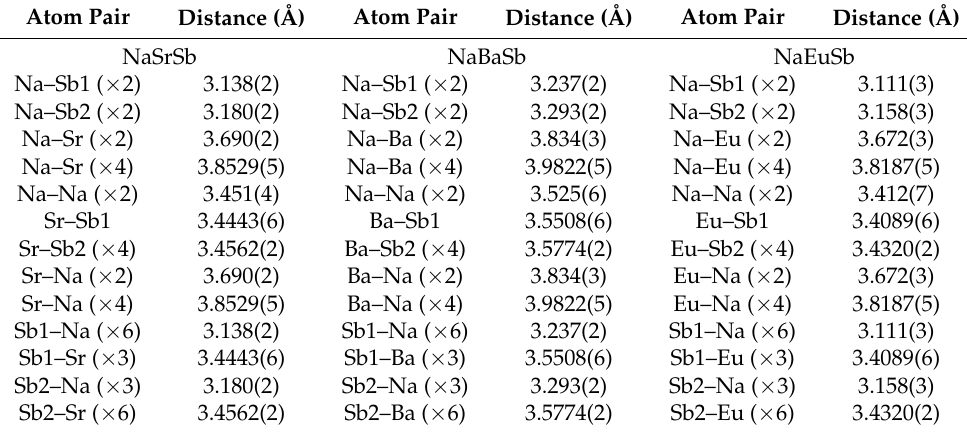
Table 3. Selected interatomic distances (Å) in NaSrSb, NaBaSb and NaEuSb. Contacts longer than 4 Å are omitted.